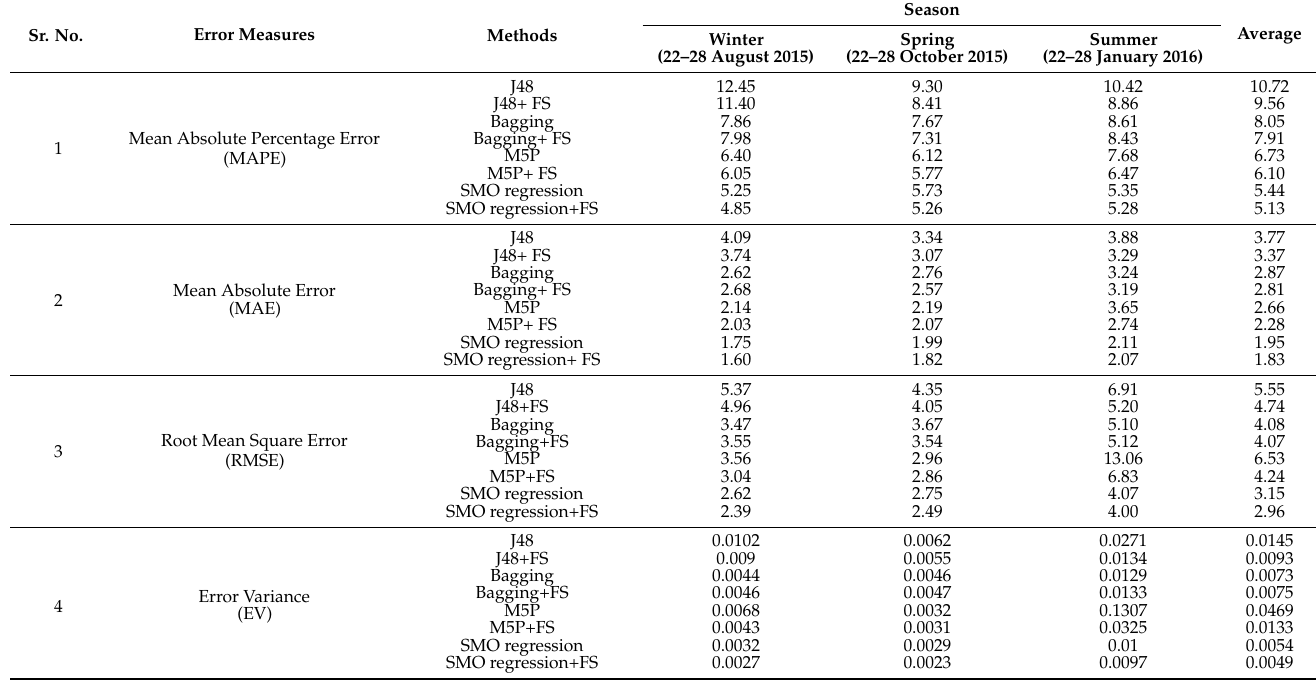
Table 4. Comparison of forecast accuracy using different error measures.